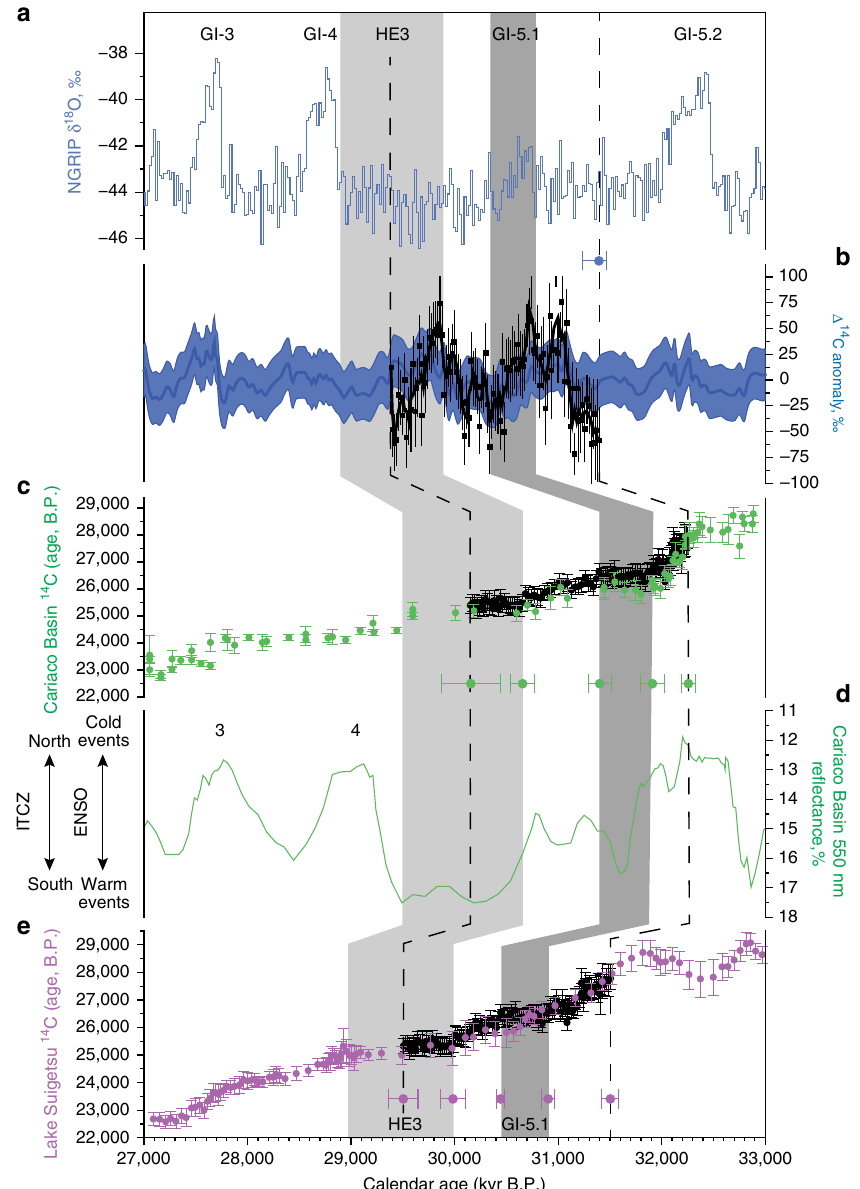
Fig. 1 High-precision alignment of 2000-year long Finlayson 8 kauri tree 14 C measurements to key datasets. Bidecadal Δ 14 C data through the kauri tree ( black fi lled circles with 3 point-running mean) compared to the Greenland ( blue ) δ 18 O and detrended 10 Be fl ux-derived Δ 14 C anomalies 10, 16 a , b . Comparison of kauri 14 C age measurements and Cariaco Basin 14 ( c and d ; green symbols ) and Lake Suigetsu 13 ( e ; purple symbols ) radiocarbon ( 14 C) calibration data sets on the modelled Hulu Cave and SG06 2012 timescales, respectively. Green re fl ectance changes preserved in the tropical Atlantic Cariaco Basin marine sequence provide a measure of the meridional migration of the Intertropical Convergence Zone (ITCZ; d ). Greenland Interstadials are numbered; Heinrich Event 3 (HE3, based on the climatostratigraphic position in MD95-2040) 17 and Greenland Interstadial 5.1 (GI-5.1) are shown by light and dark grey columns , respectively. The dashed lines denote the time range captured by the 2000-year kauri 14 C record used in this study 10 . Calendar age uncertainties for synchronization of records shown at 2 σ (95% con fi dence